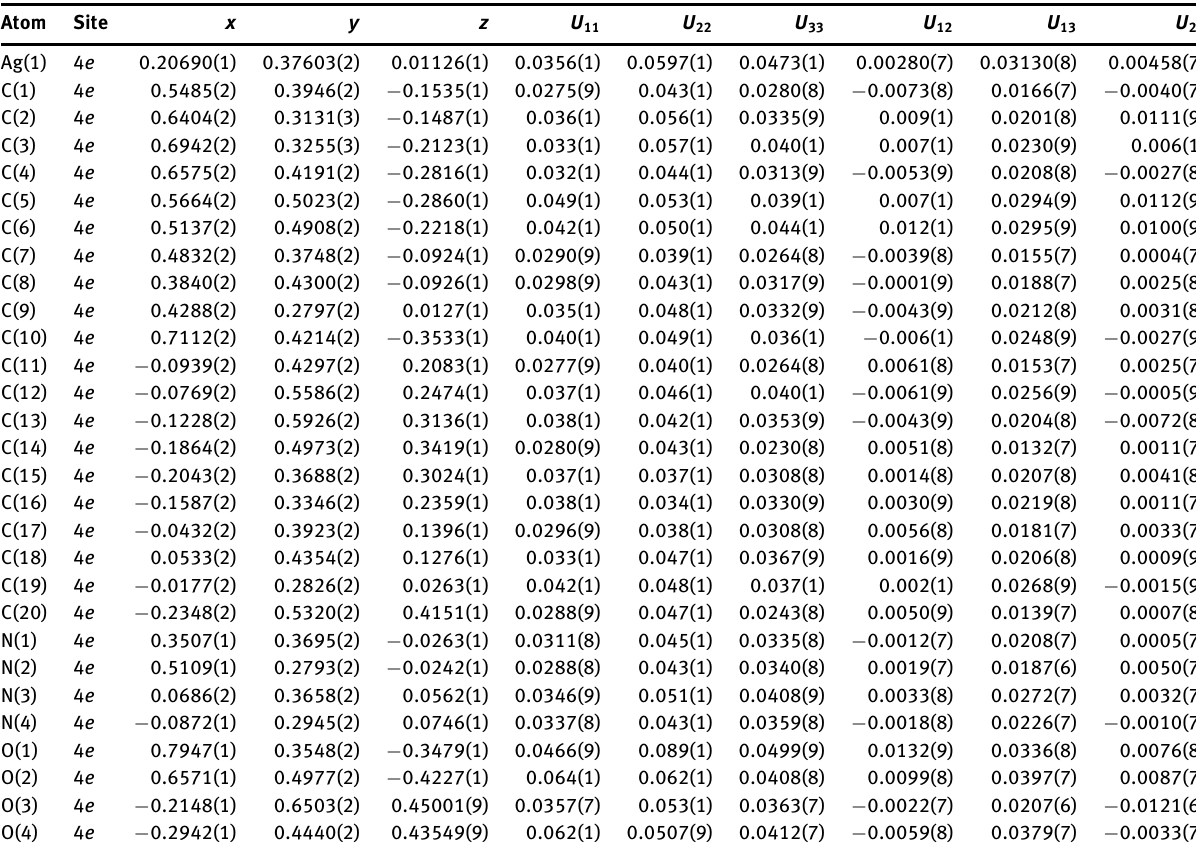
Table 3: Fractional atomic coordinate and displacement parameters (Å 2